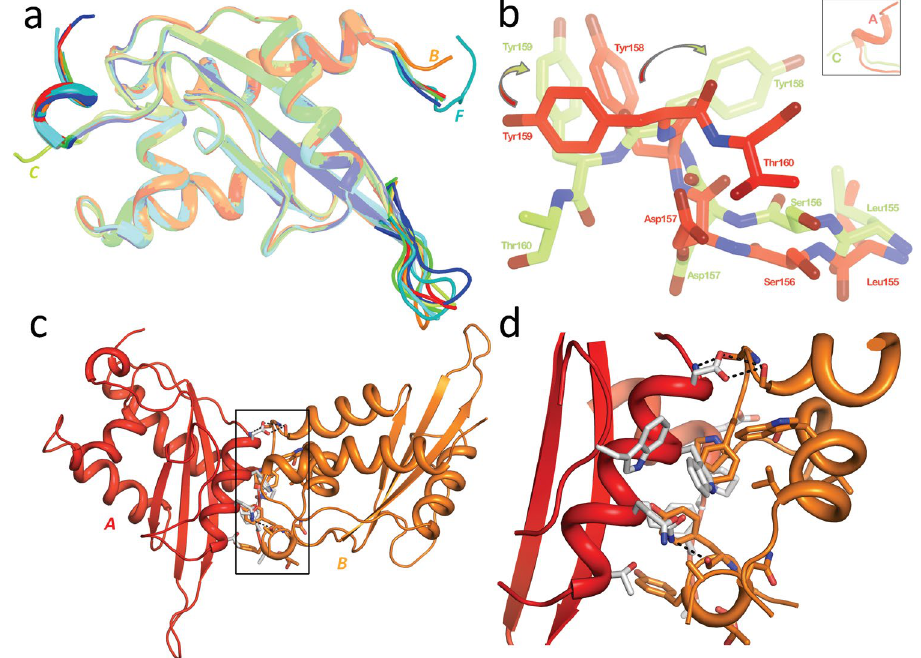
Figure 2. Structure similarity and intermolecular interaction of MpPR-1i. ( a ) Superposition of all seven monomers in asymmetric unit reveals that loop regions at termini and between longest β -sheet as the most variable parts. ( b ) Comparison of C-termini of monomers A and C. The insert reveals that monomer C and A have the overall opposite orientation starting from the peptide bond between Asp157, Tyr158, and Tyr159 in molecule C rotate ~90° clockwise compared to the equivalent residues in molecule A indicated by arrow. ( c ) Global view of intermolecular interaction of MpPR-1i. ( d ) Network of interactions between monomer A and B. The carbon atoms are colored as gray in molecule A and orange in molecule B. Oxygen atoms are shown as red and nitrogen atoms are presented as blue. The hydrogen bonds are shown as black